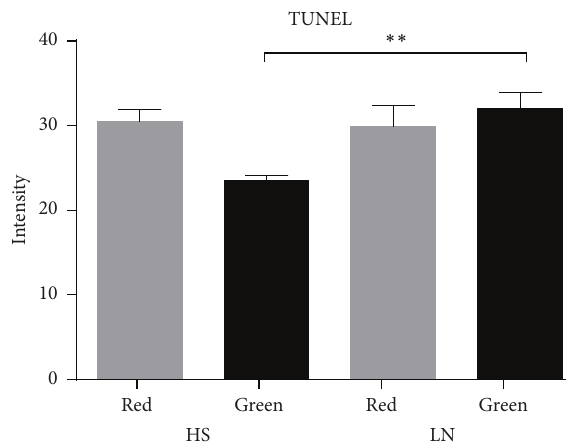
Figure 10: TUNEL assays in renal tissue of LN patients and HS. The intensity green belongs to glomerular apoptotic cells in LN biopsies, the red color belongs to nonapoptotic cells. ∗∗ 𝑃 < 0.008